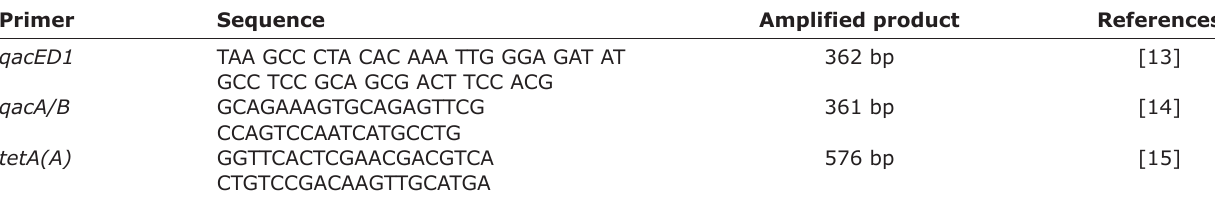
Table-1: Primers used for sequence of partial and complete fusion gene.